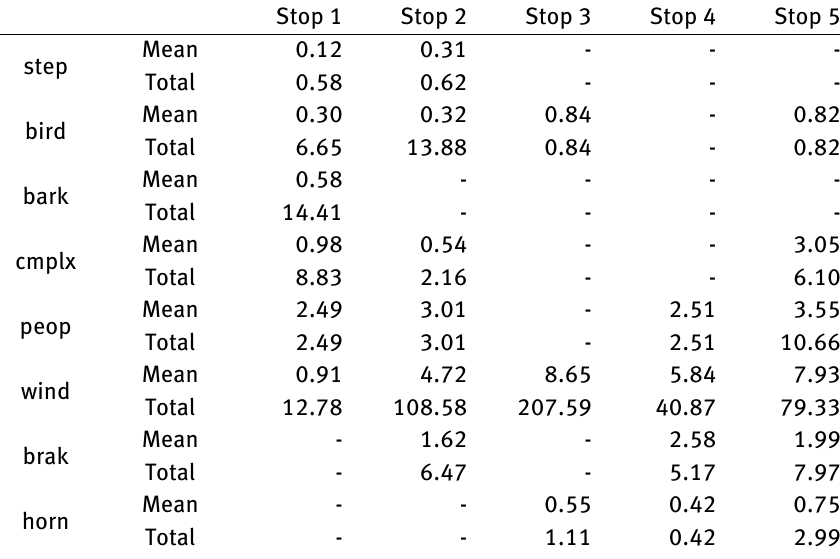
Table 1: Mean and total duration (s) of the events in each stop of the